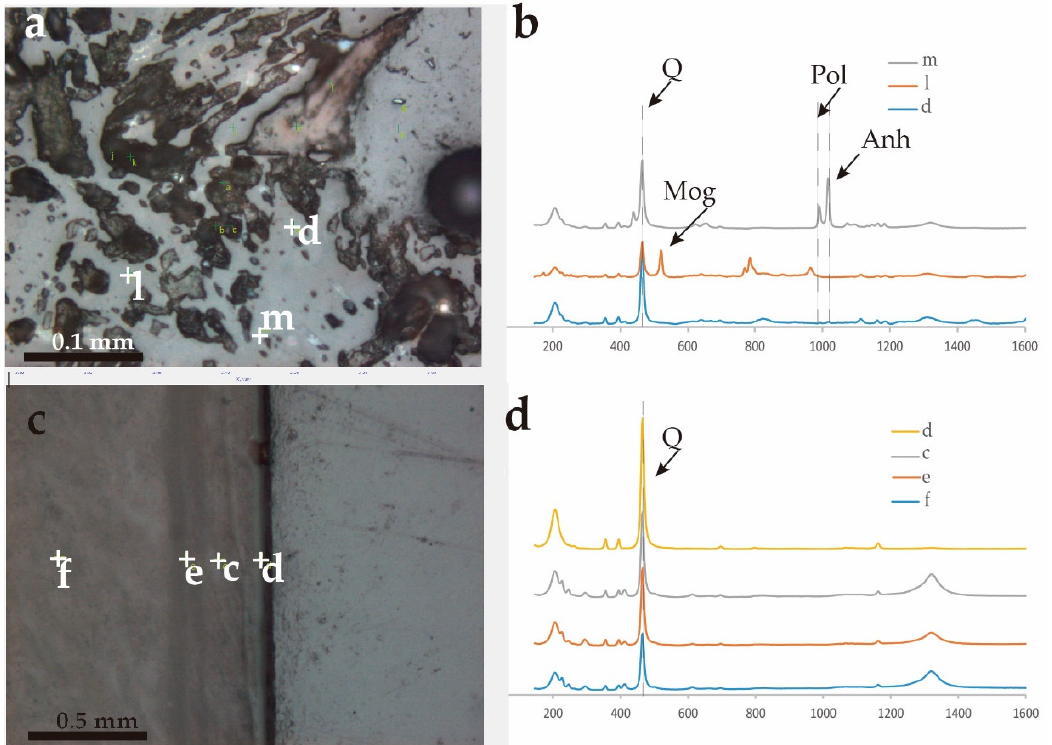
Figure 7. ( a ) Microphotograph showing the spots of measurement of Raman Spectrometry in the central part of euhedral quartz; ( b ) Image of Raman Spectra of micro-sampled spots d, l and m. Quartz (Q) appears together with moganite (Mog), anhydrite (Anh) and polyhalite (Pol); ( c ) Microphotograph showing the spots of measurement of Raman Spectrometry in the external part of a euhedral quartz; ( d ) Image of Raman Spectra of micro-sampled spots f, e, c and d. Quartz, in this case, was pure and more crystalline (X-axis represents Raman Shift /cm −1 ).